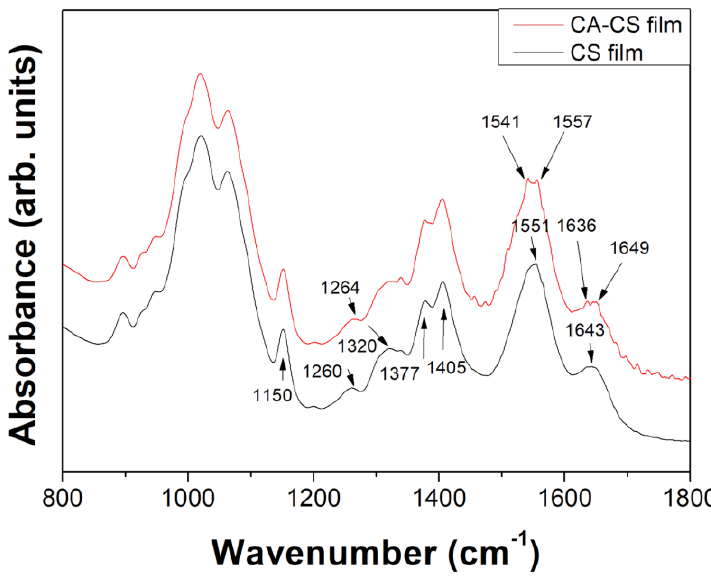
Figure 10. ATR spectra of a neat chitosan film (CS film) and a mCLEAs-modified chitosan film with caffeic acid derivatives (CA-CS film).